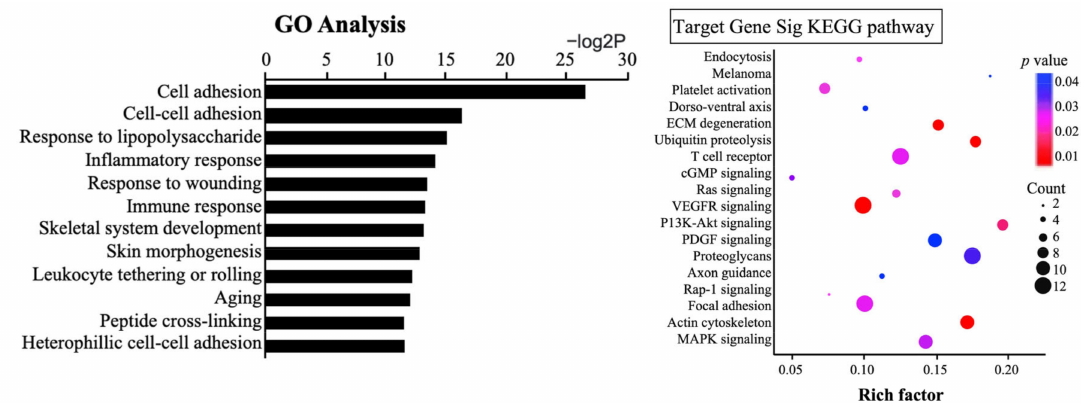
Figure 7. GO analysis and KEGG pathway analysis. Go analysis showed the top 12 miRNA functions. KEGG pathway analysis showed the top 18 pathways regulated by target miRNAs. ( p <